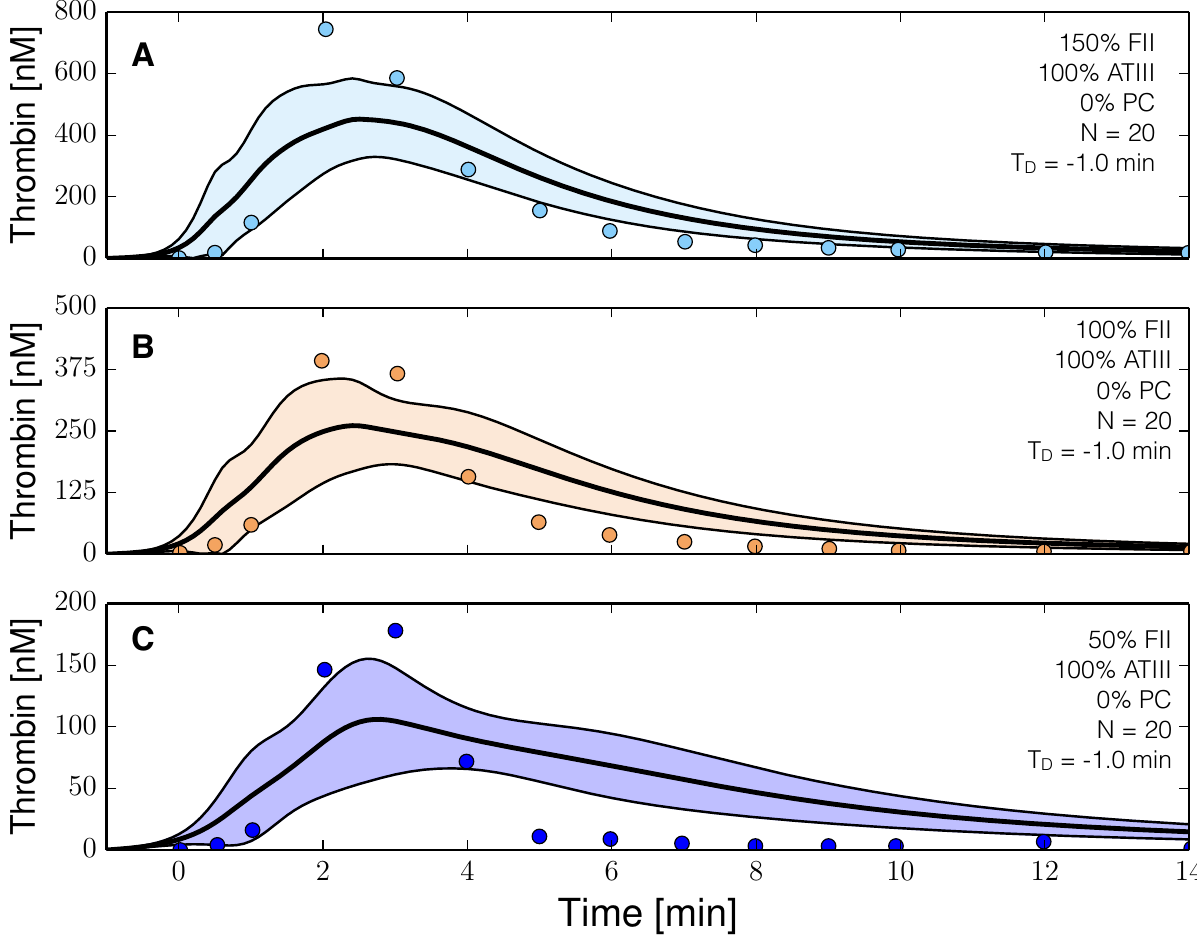
Figure 3. Reduced order coagulation model training simulations. Reduced order coagulation model parameters were estimated using particle swarm optimization (PSO) without the protein C pathway as a function of prothrombin. Solid lines denote the simulated mean value of the thrombin profile for N = 20 independent particles, points denote experimental data. The shaded region denotes the 99% confidence estimate of the mean simulated thrombin value (uncertainty in the model simulation). ( A – C ) depict training data and results for 150%, 100% and 50% of physiological prothrombin levels in the absence of protein C pathway. The experimental training data was reproduced from the study of Butenas et al. [40]. Thrombin generation in these experiments was initiated using 5 pmol/L FVIIa-TF in the presence of 200 µ mol/L of phospholipid vesicles (PCPS). As depicted in ( A – C ) the prothrombin levels were at 150%, 100% and 50% of their physiological concentration in the absence of protein C pathway. All factors and control proteins in these experiments were at their physiological concentration unless otherwise